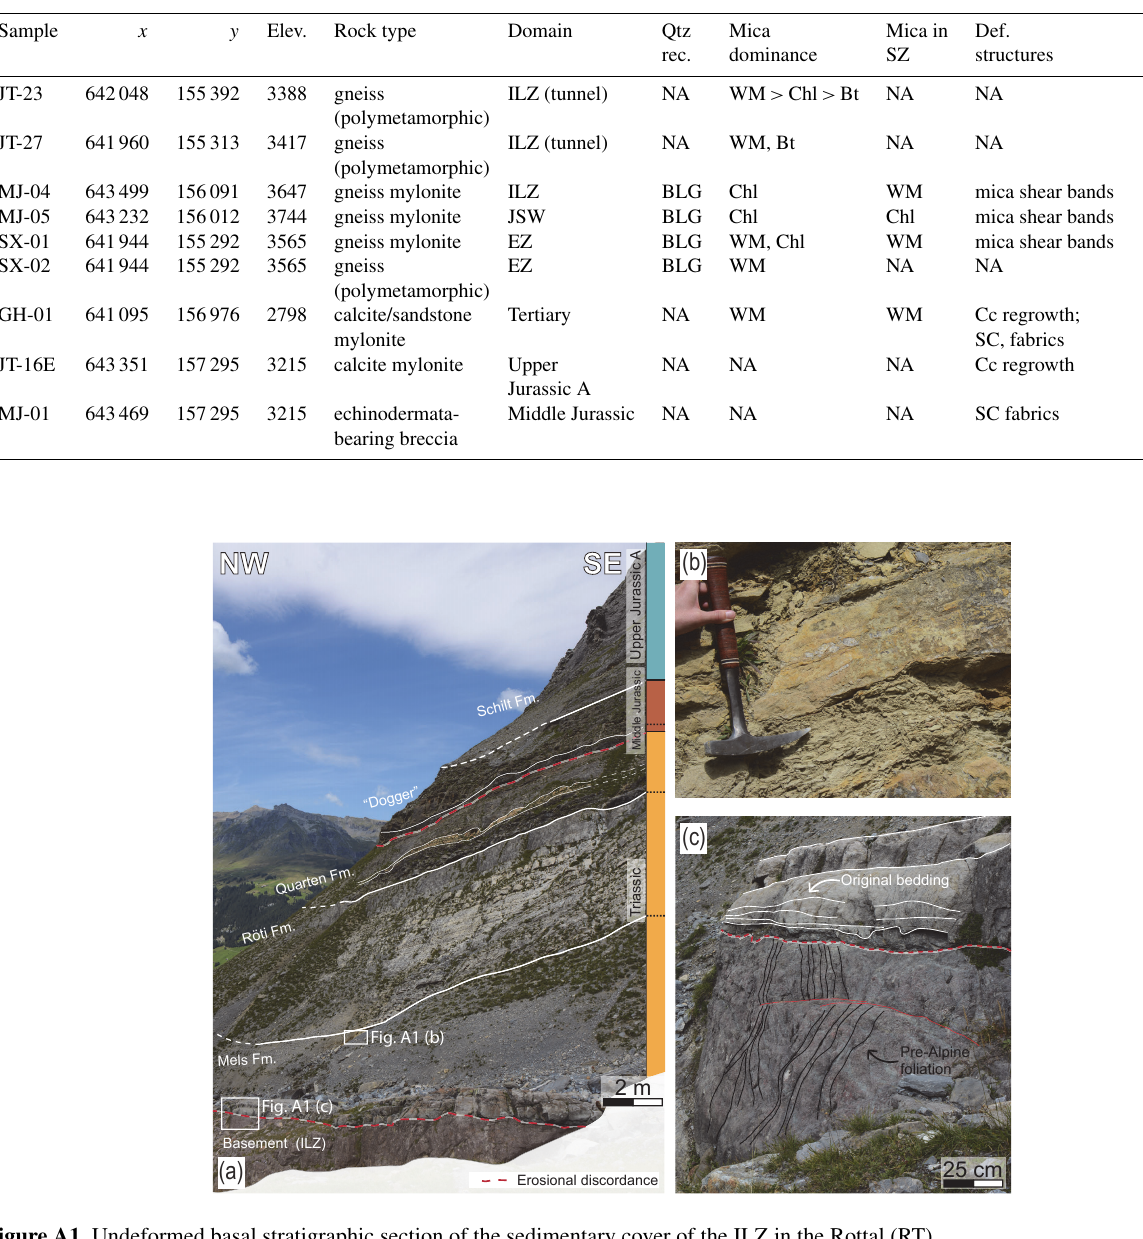
Table A1. Basic data for selected samples used in Figs. 3 and 8. Thin section description for dominant dynamic quartz recrystallization mechanism (BLG: bulging), dominant mica and mica growth in shear zone (if applicable). Coordinates are given in the Swiss coordinate system (CH1903). For shear zone generation discussion, see Sect. 4.2.1. NA – not available.